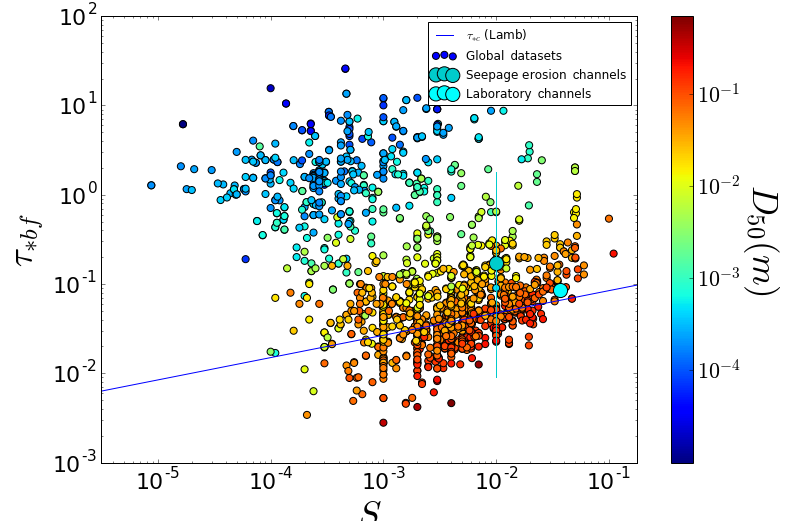
Figure 3. Bank-full Shields stress as a function of stream gradient. Coarse-grained rivers exhibit low Shields stresses with a moderate dependence on slope that roughly follows but is offset from the slope-dependent relation of Lamb et al. (2008) for critical Shields stress (solid line). Fine-grained rivers cluster well in excess of the threshold of motion. River channels originating in sandy substrates found in natural (Devauchelle et al., 2011) or laboratory (Reitz et al., 2014) environments are shown to be in the Shields stress space typically populated by gravel-bedded rivers.